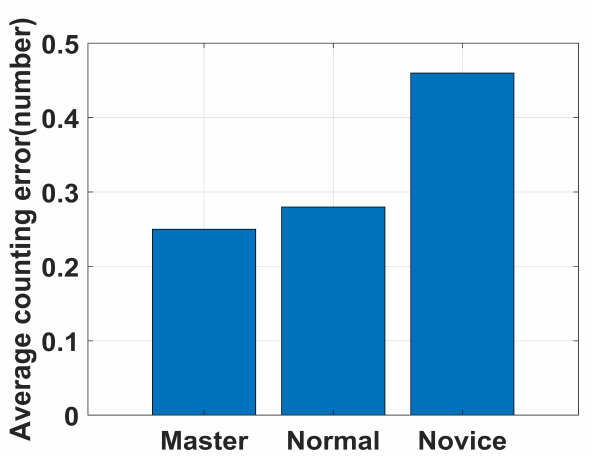
Figure 12. Average counting error with varied user.